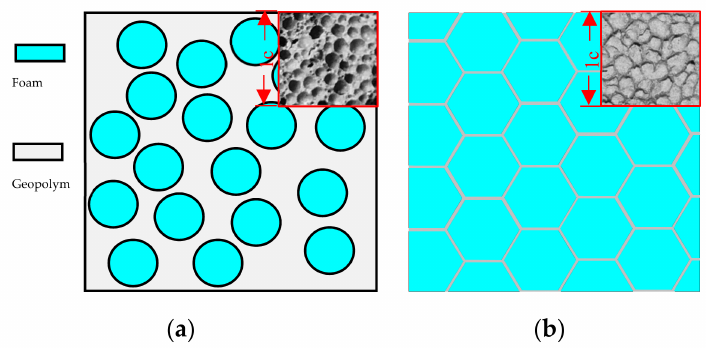
Figure 3. ( a ) The model of a two-dimensional structure with pores of FBLPG at 3% hydrogen peroxide; ( b ) the model of a two-dimensional structure with pores of FBLPG at 7% hydrogen